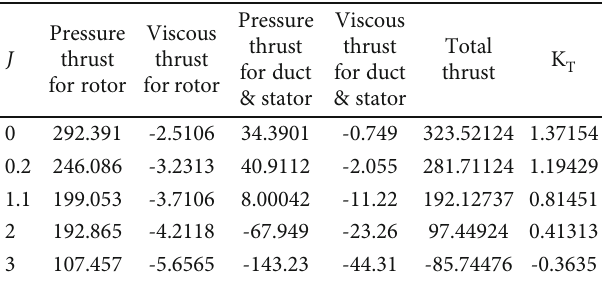
Figure 8: Three-dimensional geometry of the linear jet propulsion system. Table 7: Thrust force calculated for the linear jet system with a stator.